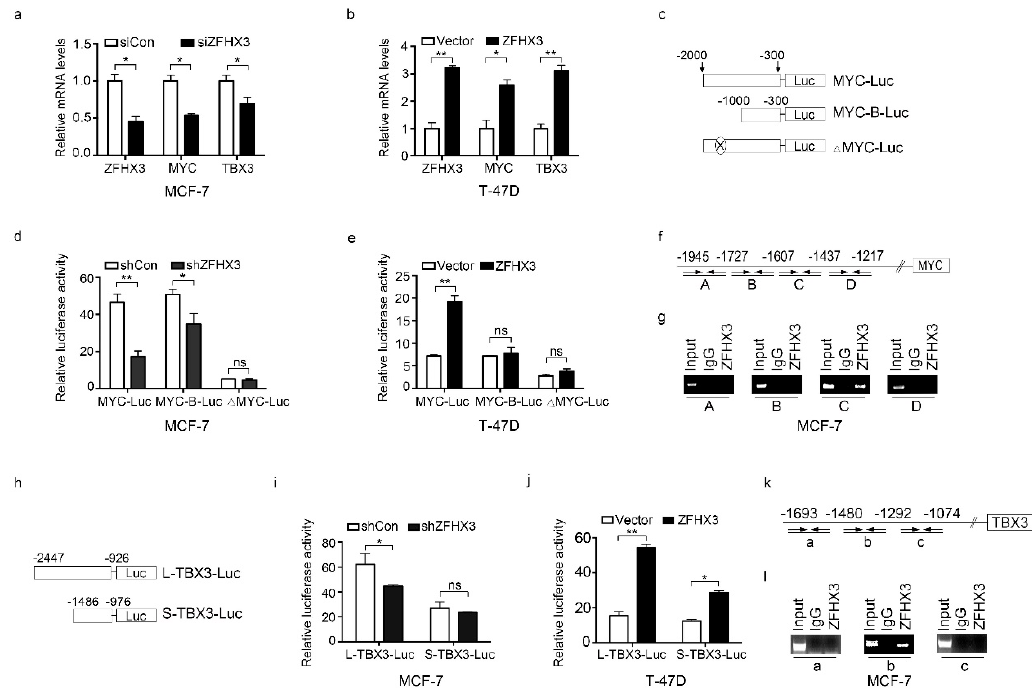
Figure 4. ZFHX3 activates MYC and TBX3 transcription by binding to their promoters in ER + MCF-7 and T-47D breast cancer cells. ( a , b ) ZFHX3 silencing in MCF-7 cells decreased, while ectopic expression of ZFHX3 in T-47D ( b ) cells increased, mRNA levels of MYC and TBX3 , as detected by real-time PCR. ( c ) Schematic for the construction of different MYC promoter-luciferase reporter